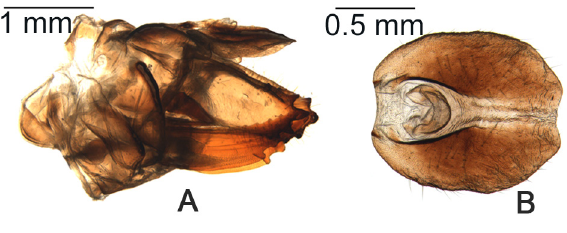
Fig. 5. Atracis patefacta sp. nov., paratype, ♀ (NWAFU). A . Female genitalia, right lateral view. B . Anal segment, dorsal